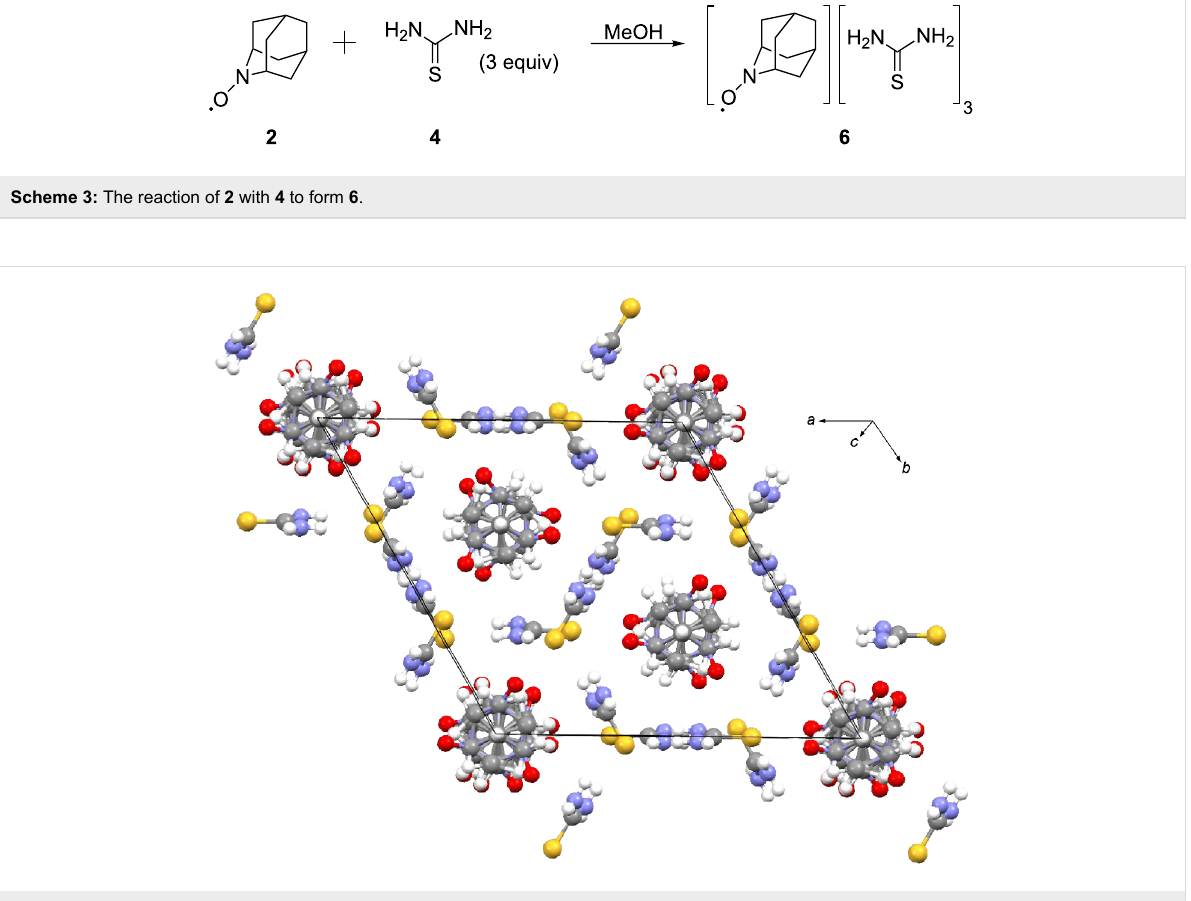
Figure 4: Crystal structure of the inclusion compound 6 obtained by X-ray analysis.